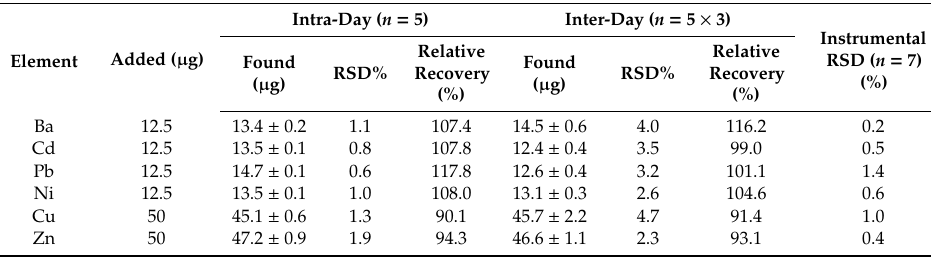
Table 3. Intra-day and inter-day results of the proposed